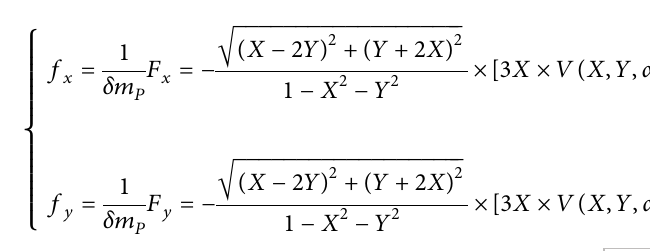
Figure 1. Four disks are fixed and connected together through circumferentially evenly distributed tie rods, and both ends of the rotor are supported by sliding